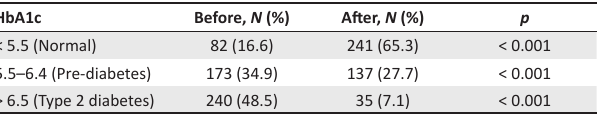
TABLE 4: Proportion of participants with HbA1c levels in the normal, pre- diabetes or type 2 diabetes ranges before and after initiation of a low- carbohydrate diet ( N = 495).